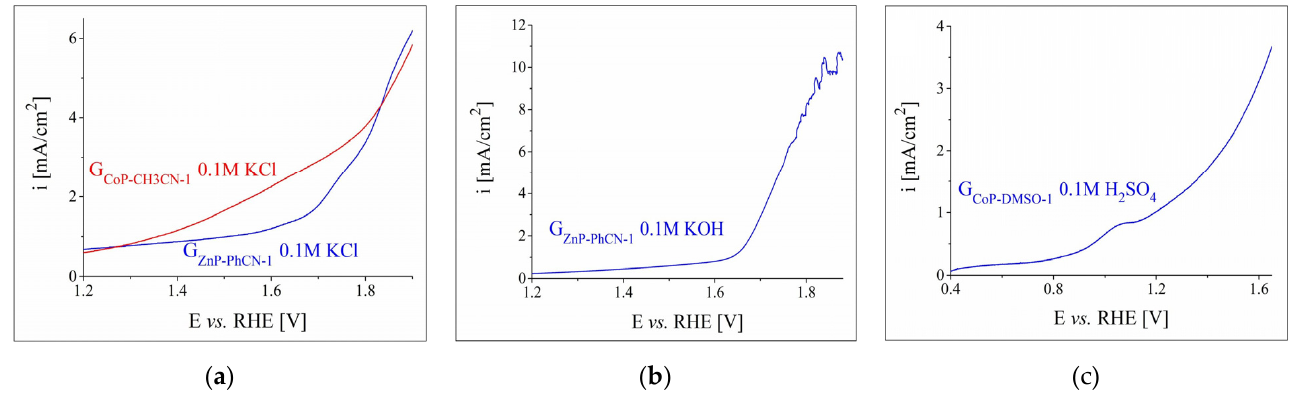
Figure 3. LSVs obtained during OER experiments on the most electrocatalytically active metallopor ‐ phyrin ‐ modified electrodes, in: ( a ) 0.1 M KCl, ( b ) 0.1 M KOH, and ( c ) 0.1 M H 2 SO 4 electrolyte solu ‐ tions, at v = 1